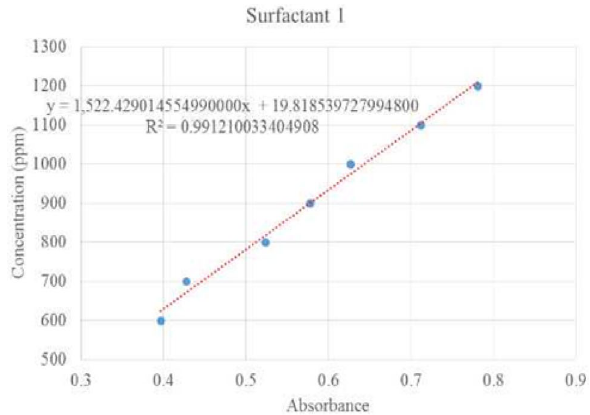
Fig. 4 Calibration curve for surfactant 1